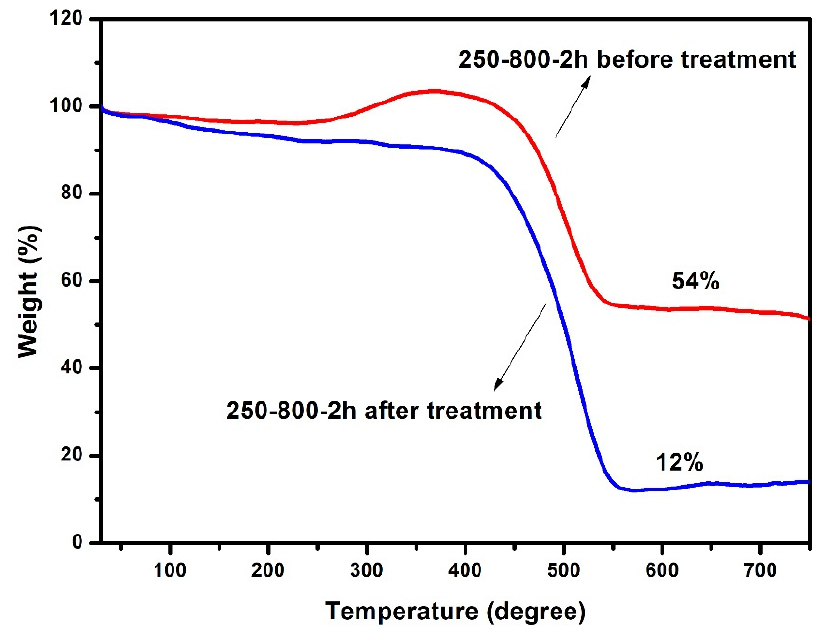
Figure 7. TG curves of the 250-800-2h catalyst before and after acid treatment.